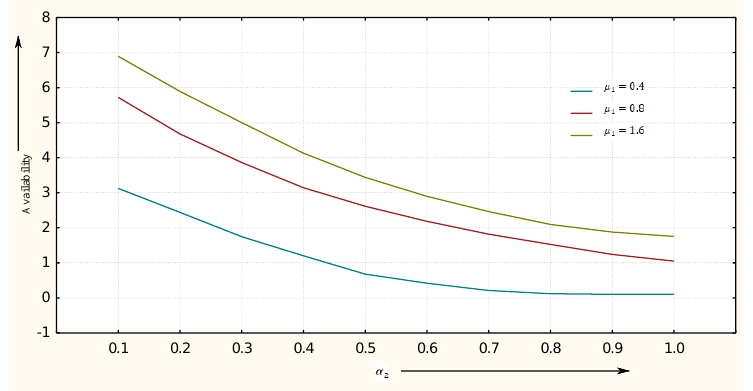
Figure 8. Behaviour of availability w.r.t 𝛼